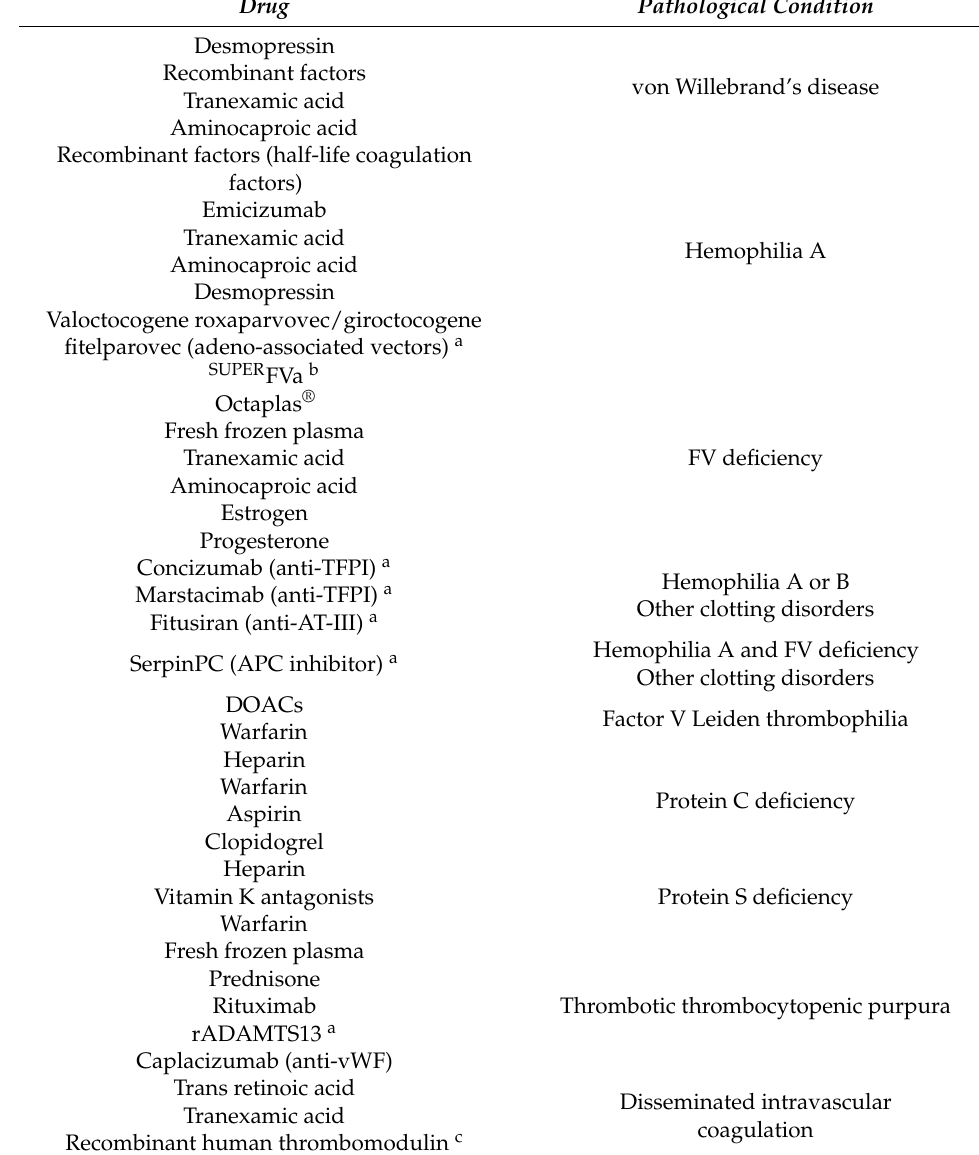
Table 1. Homeostasis-modifying treatments: therapeutic